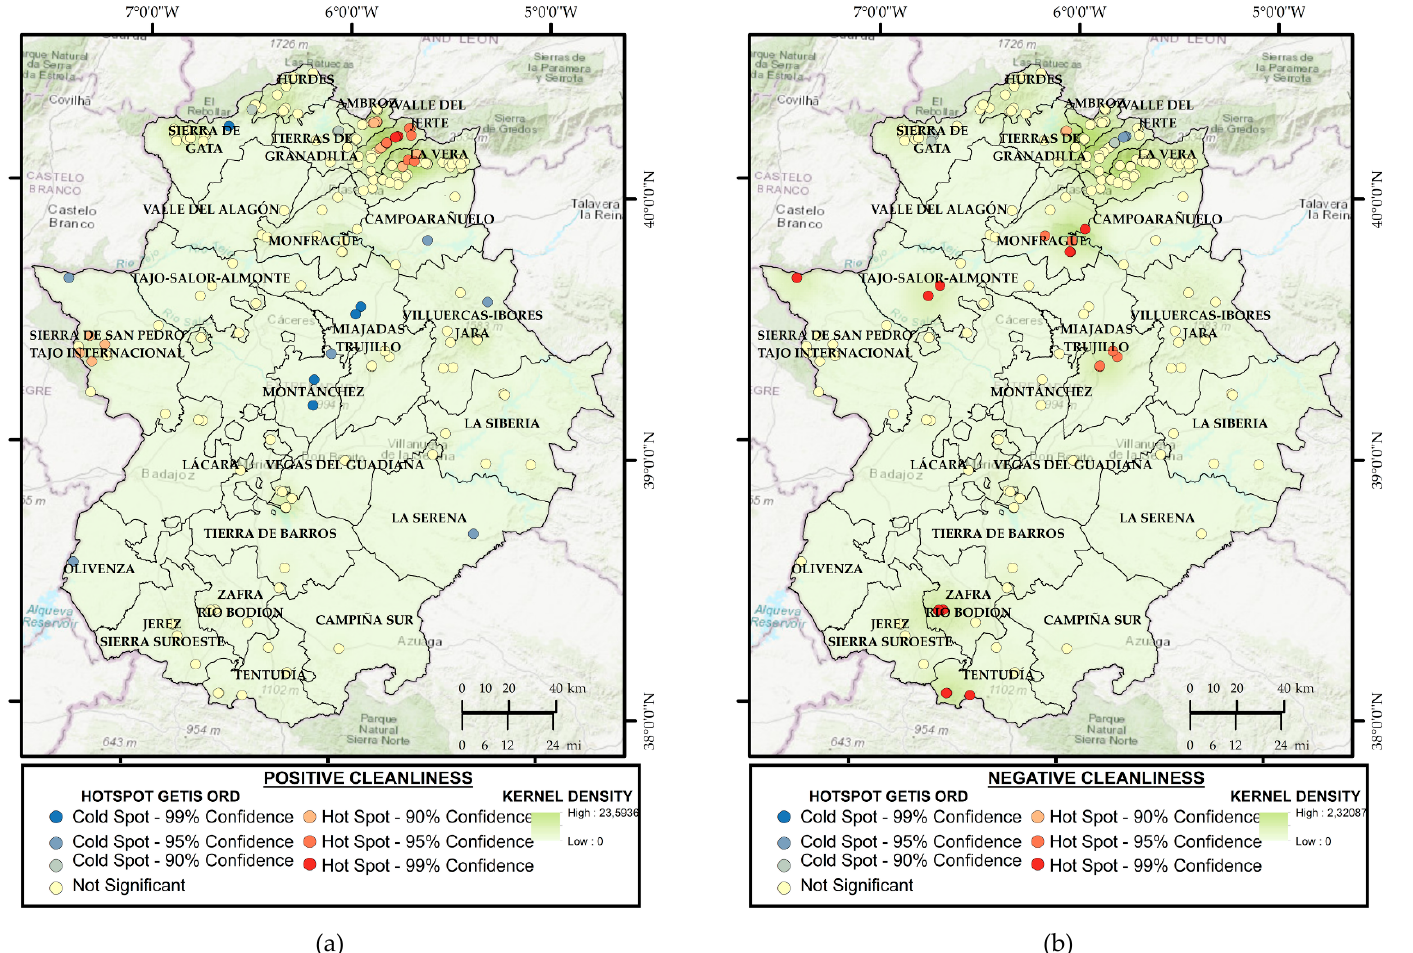
Figure 7. Gi Getis Ord on Cleanliness Positive ( a ) and Negative ( b ) mentions.